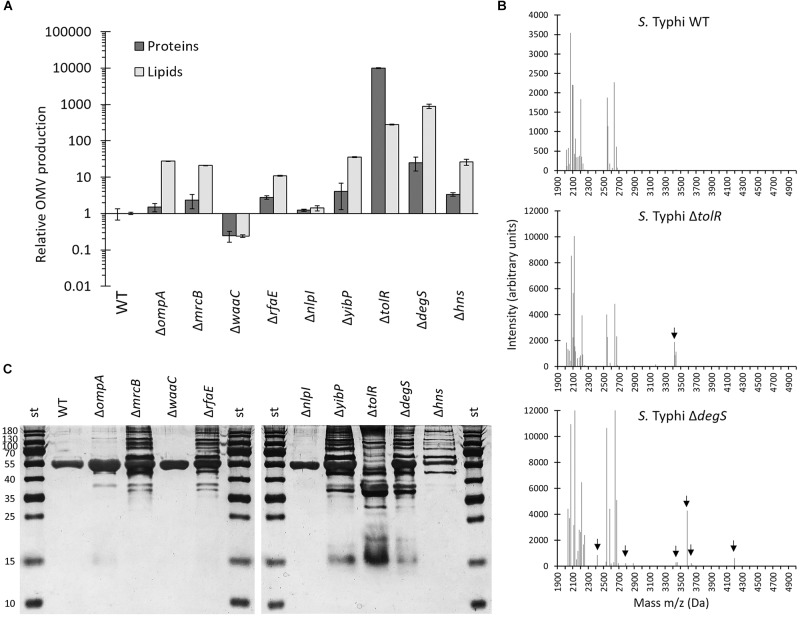
(A) OMV production of S. Typhi WT and S. Typhi Δzzz mutants. Bacteria were grown in LB to stationary phase, and OMVs were extracted. Relative fold of OMV production was obtained by quantitating both the protein and lipid content (McBroom et al., 2006; Deatherage et al., 2009; Schwechheimer et al., 2015), normalizing to CFU/ml, and dividing by (CFU/ml)-normalized OMV production obtained with the S. Typhi WT. (B) MALDI-TOF mass spectrometry of OMV extracts. Arrows indicate differences with S. Typhi WT (n = 2, representative experiment). (C) SDS–PAGE of OMV extracts obtained from S. Typhi WT and S. Typhi Δzzz mutants. Proteins were visualized by silver staining.